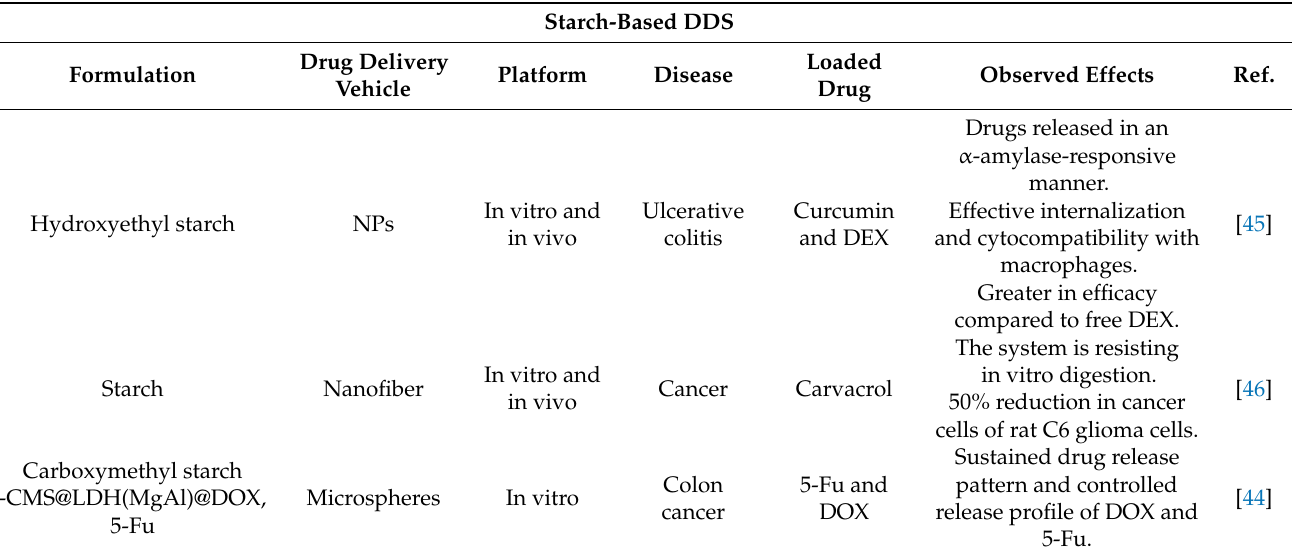
Table 4. Summary of studies on starch-based DDSs.